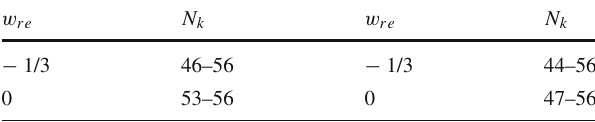
Table 13 Summary of the allowed range for the number of e -folds for each EoS parameter w re when the dimensionless parameter α is fixed to α = 0 . 0185. The left and right tables corresponds to a 5-dimensional Planck mass of M 5 = 10 5 TeV and M 5 = 10 12 TeV